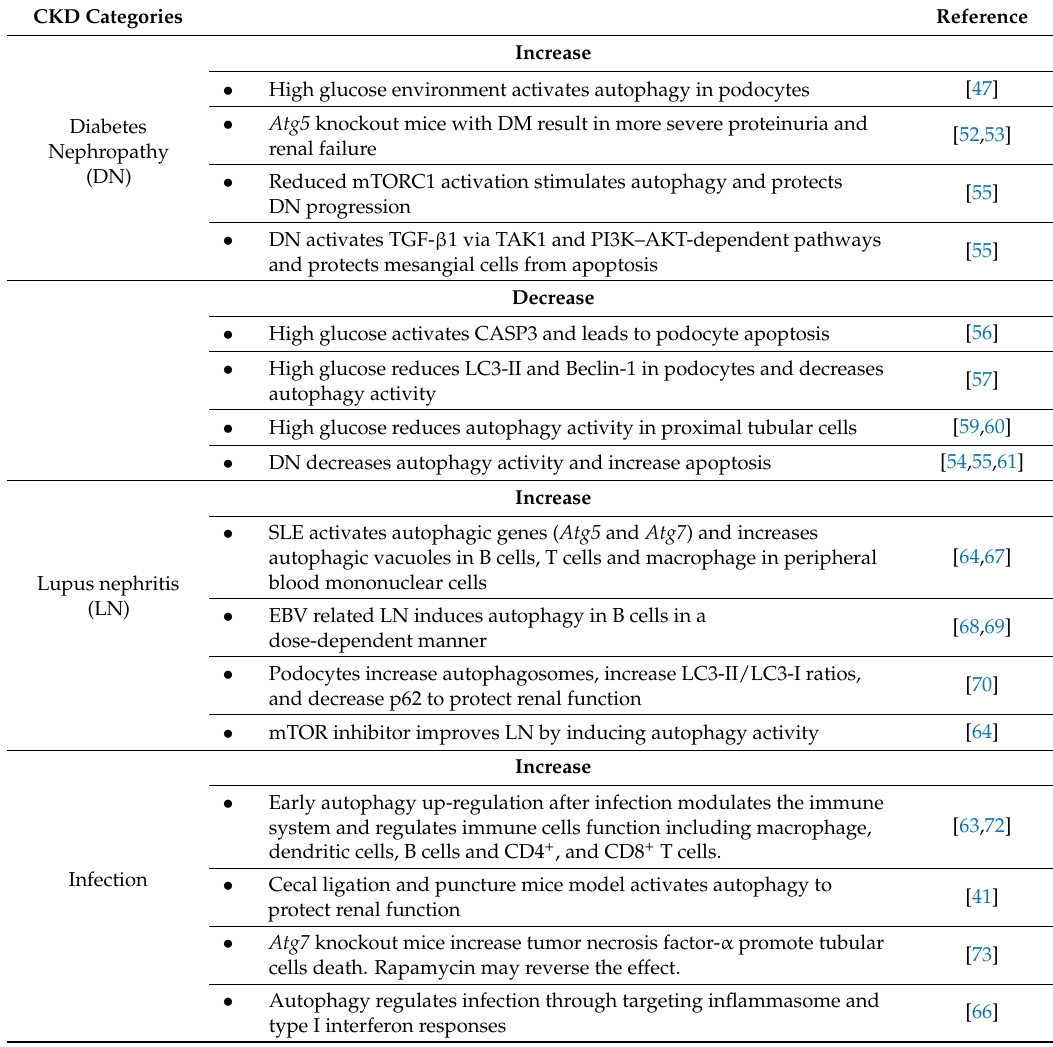
Figure 4. Diagram depicting the roles of autophagy in various chronic kidney disease. DN: diabetic nephropathy; LN: lupus nephropathy; APCKD: adult polycystic kidney disease. Table 1. Overview of the autophagy in chronic kidney diseases (CKD).